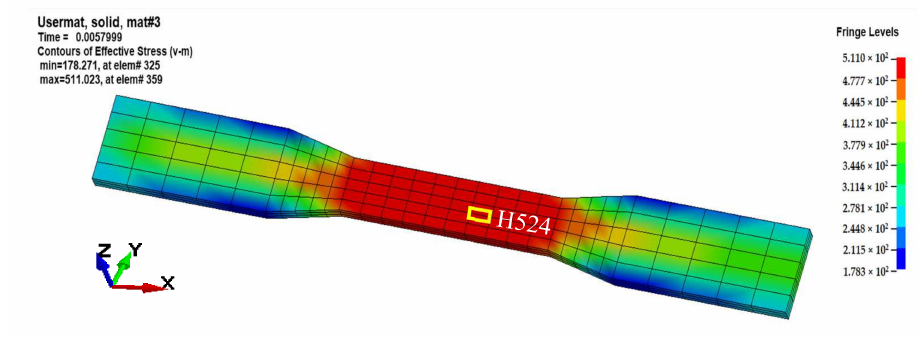
Figure 12. Contours of the finite element model of effective stress.